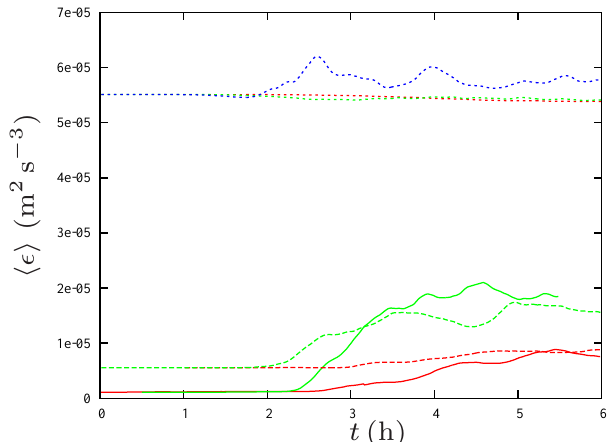
Figure 4. Temporal evolution of turbulence dissipation rate h (cid:15) k i for the weak forcing case (red lines), moderate forcing case (green lines), and strong forcing case (blue line). Solid lines: 1 = 2m; dashed lines: 1 = 4m; dotted lines: 1 = 10m.